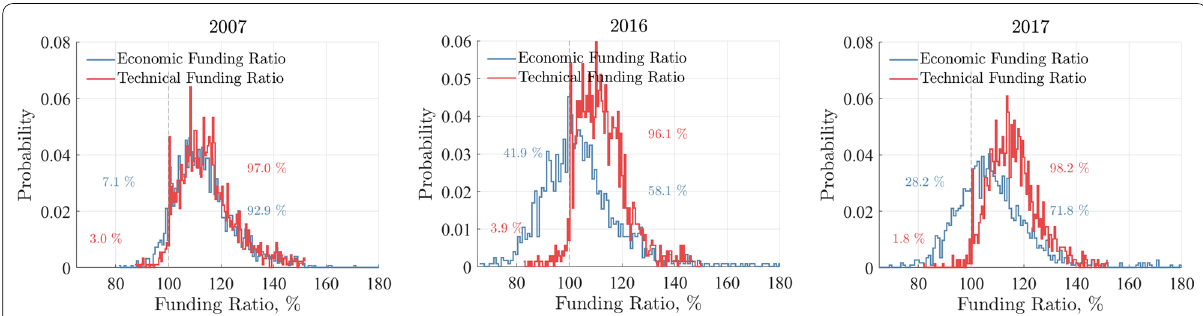
Fig. 5 Distribution of Funding Ratios. Histogram of pension funds’ technical and economic funding ratios in 2007, 2016 and 2017. Economic funding ratios-based retiree pension liabilites evaluated at market interest approximated with conversion factors retrieved from PPCmetrics, (2020). The sample includes only private and public funds without state guarantees, and only includes funds with a funding ratio between 81.5 and 152.3% (0.5th–95th percentile range of the overall sample)